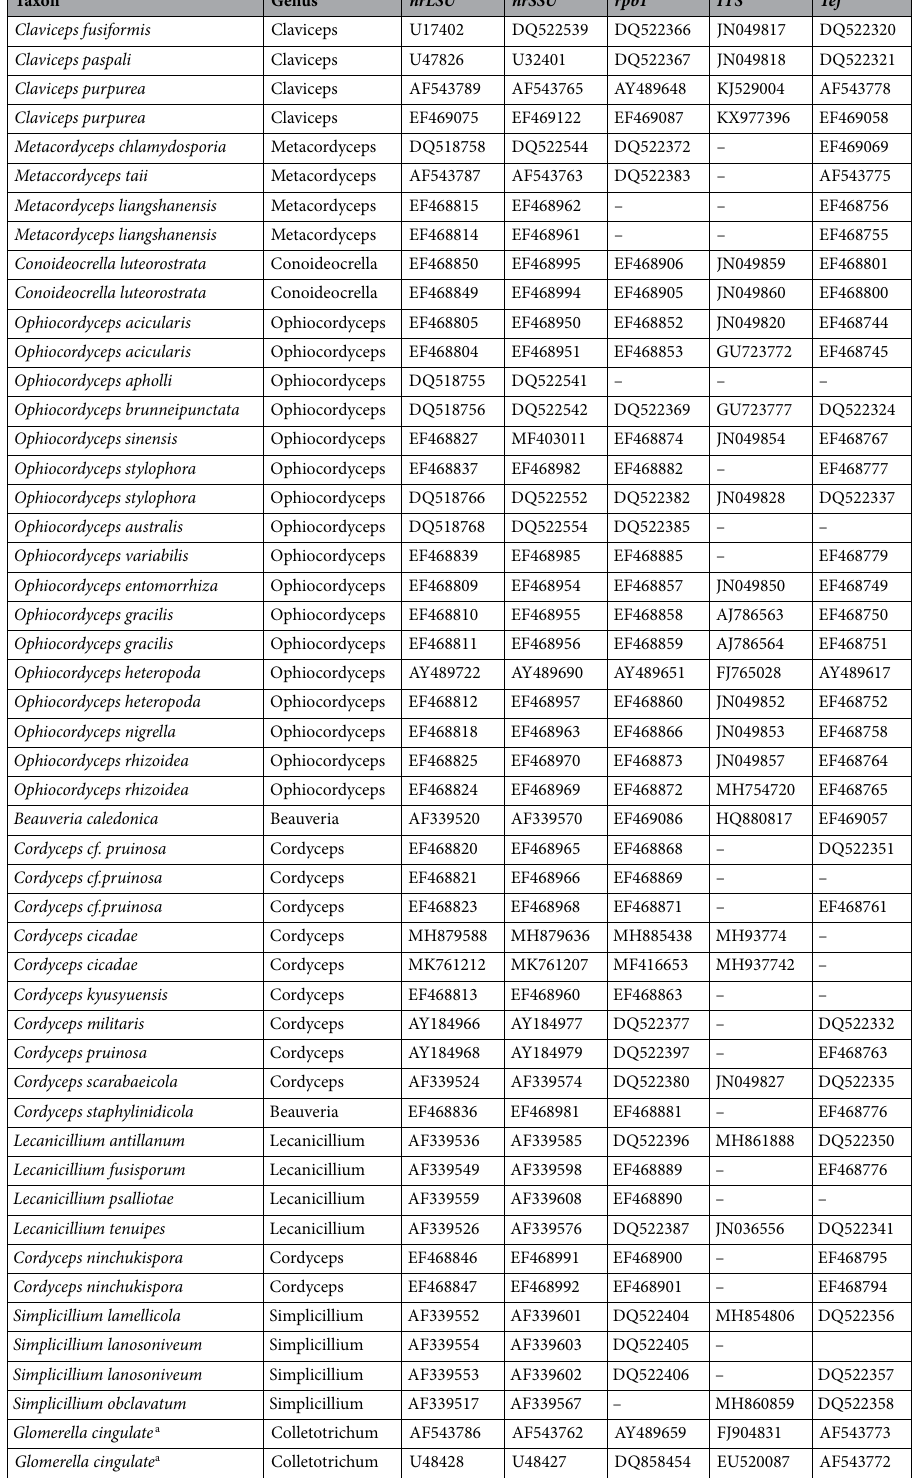
Table 2. Representative taxa information and GenBank accession numbers for sequences used in current study. –: no accession number recorded. a